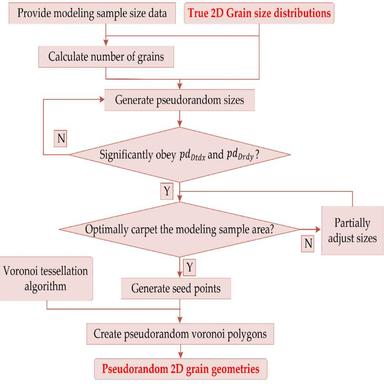
Flow chart of pseudorandom geometry method.